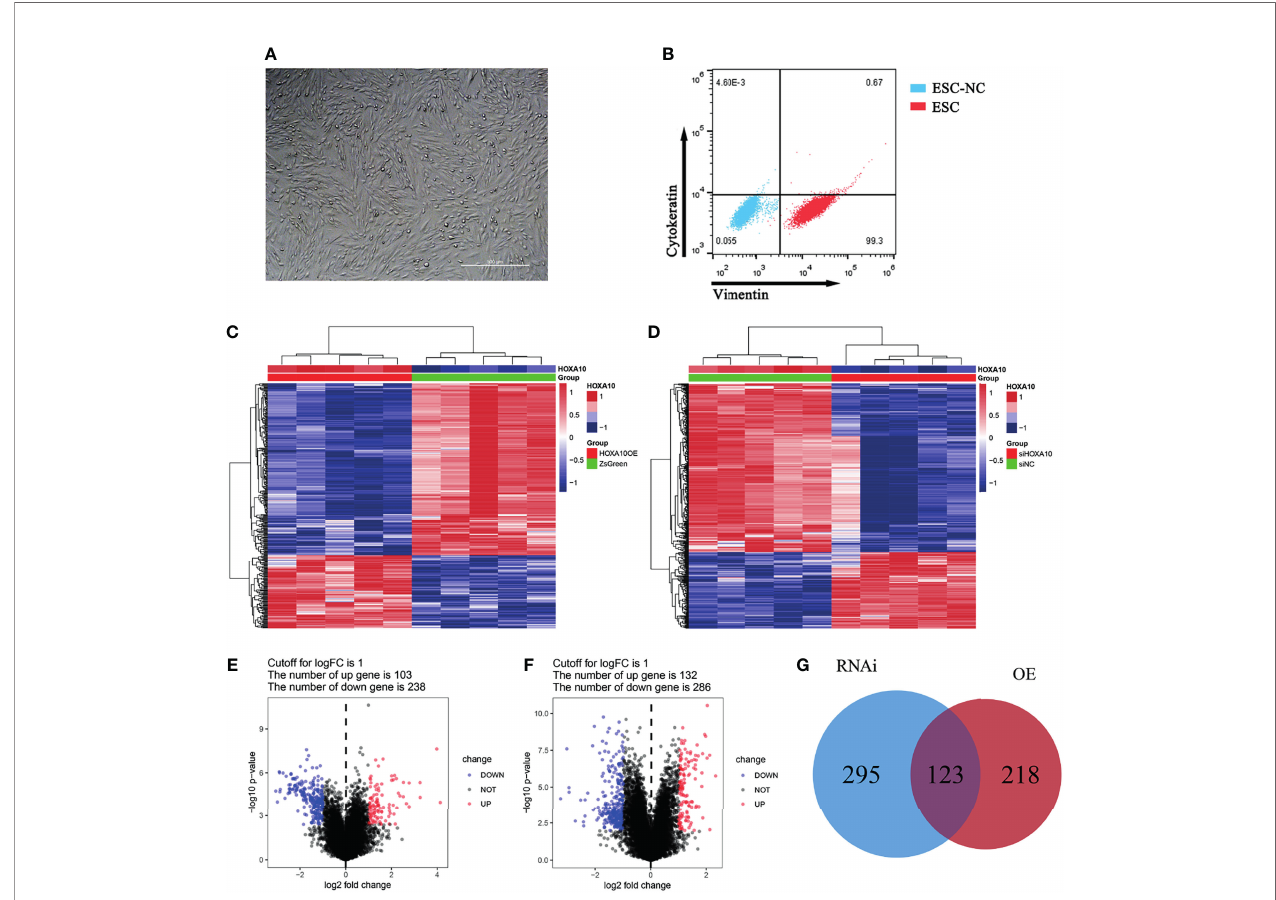
FIGURE 2 | DEGs screening between HOXA10 over-expression and HOXA10 silence ESC. (A) ESC culturation. (B) ESC identi fi cation. (C) Heatmap of DEGs between HOXA10OE group and ZsGreen group. (D) Heatmap of DEGs between siHOXA10 group and siNC group. (E) Volcano plot of DEGs between HOXA10OE group and ZsGreen group. (F) DEGs between siHOXA10 group and siNC group. (G) The union of two sets of DEGs (HOXA10OE, HOXA10 over-expression ESC; ZsGreen, control for over-expression group; siHOXA10, HOXA10 silence ESC; siNC, control for silence